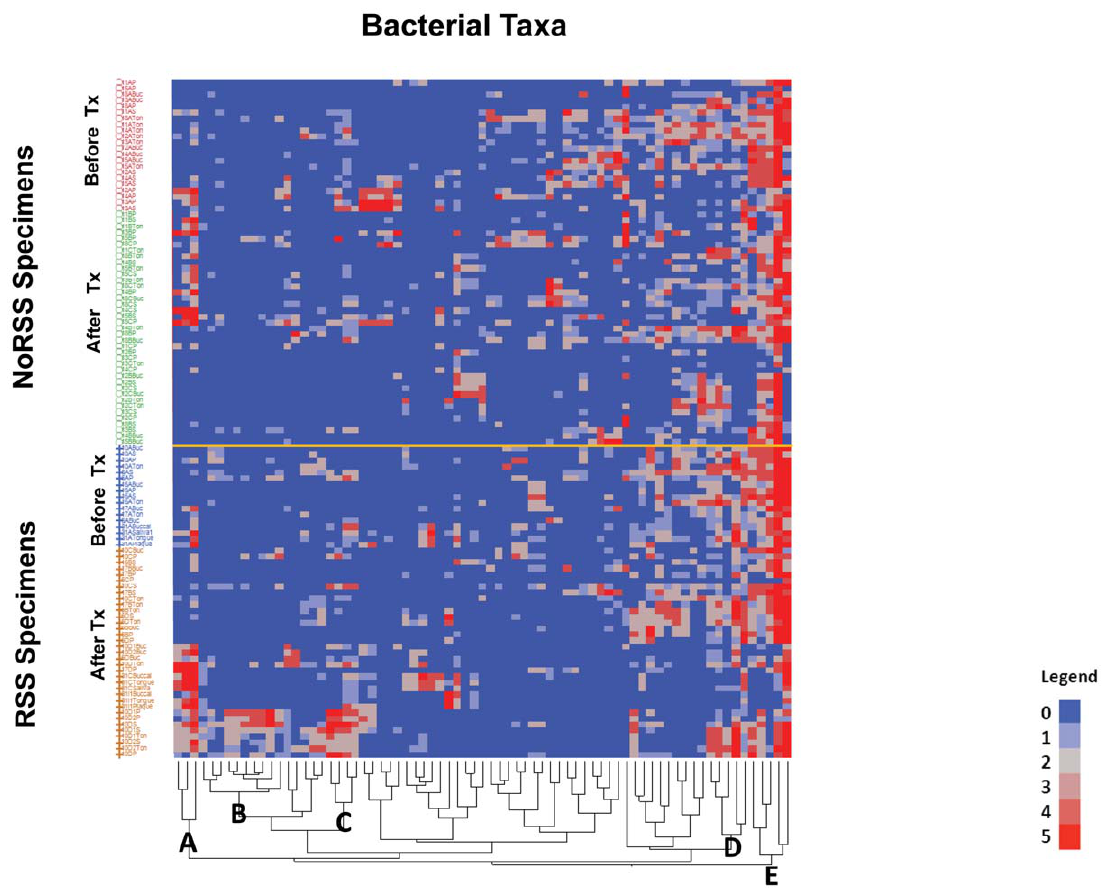
Figure 7. Cluster Analysis of RSS vs. NoRSS. Clinical specimens (113) from 11 patients (rows) by probes (73) (column). To be included each probe must have a median sum expression of 17 positive specimens for that probe. The sum was taken across the 113 specimens for each bacteria probe and the median was determined. A total of 73 out of 155 probes passed this requirement and were used in the two-way cluster (Table S2 lists the probes). The specimens were first divided into four groups RSS before and after transplant vs. NoRSS before and after transplant groups. Clustering was performed in each of the four groups. A second clustering was applied to probes. Cluster A specimens are composed of probes that were positive for Camplylobacter rectus and/or C. concisus . Cluster B is composed of positive probes Campylobacter rectus and/or C. concisus, two probes for Streptococcus, namely Streptococcus intermedius and/or S. constellatus and Streptococcus anginosus and/or S.intermedius . Also included in Cluster B are positive probes for Dialster invisus, Eubacterium infirmum and five different probes for the genus Selenomonas . Cluster C is composed of positive probes for Parvimonas micros Dialaster invisus and Eubacterium saburreum . Cluster D and E represent common oral bacterial taxa. Analysis was performed using JMP (Cary, NC), hierarchical two-way clustering with Ward’s distance measure applied to the normalized fluorescence intensity signal from the microarray data, on a 0 to 5 scale. NoRSS=patients who do not develop respiratory signs and symptoms. RSS=patients who develop respiratory signs and